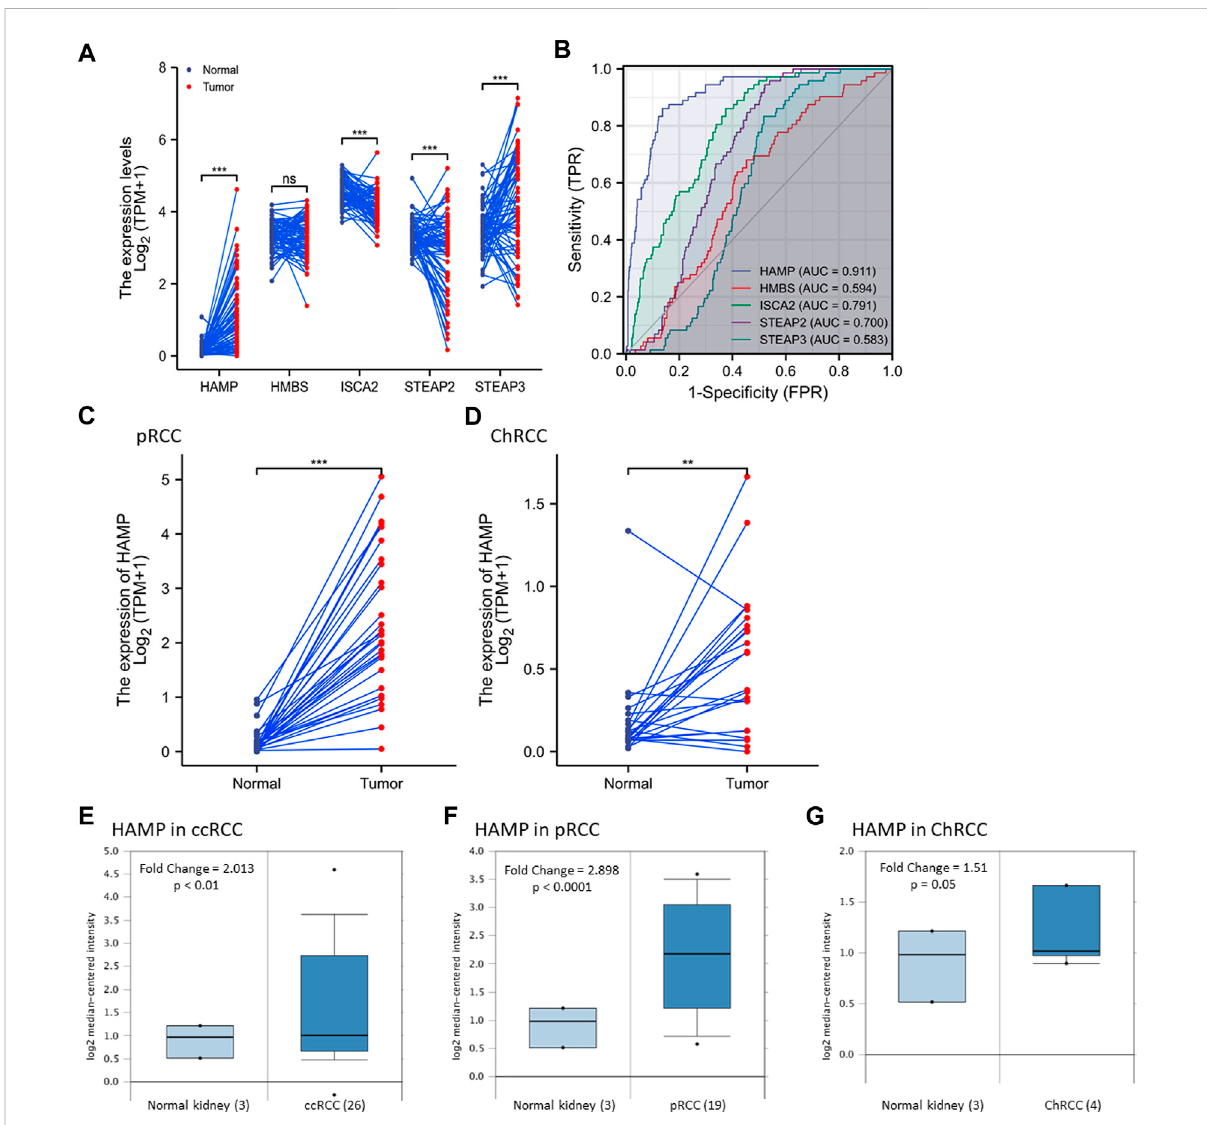
FIGURE 1 HAMP expression is upregulated in kidney cancers. (A) Gene expression was compared using the case-matched normal kidney and ccRCC tissues (TCGA -KIRC) from 72 cases. The p -values werederived from a paired t -test. (B) A Receiver Operating Characteristic (ROC) curve analysis for the diagnostic performance of iron-modulating gene expression in ccRCC tissues. AUC: Area under the ROC curve. (C,D) HAMP expression was compared using the case-matched normal kidney and ccRCC tissues (TCGA -KIRC) from 72 cases. The p -values were derived from a paired t -test. (E – G) HAMP expression levels were assessed using the cDNA microarray dataset as reported (Yusenko et al., 2009). The p -value was from a Student t -test. The asterisks indicate a signi fi cant difference between the two groups. ** p < 0.01; *** p < 0.001; ns, no signi fi